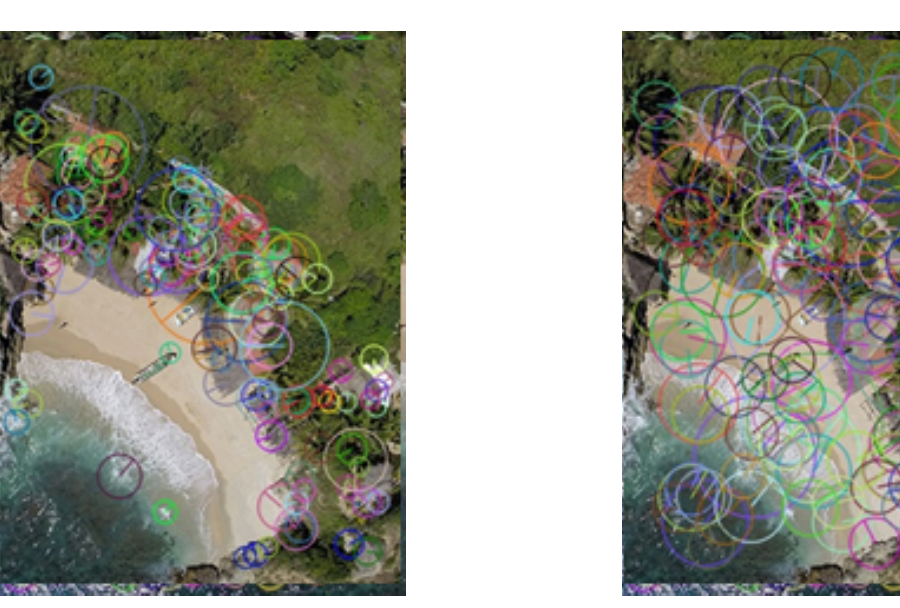
Figure 7. 10% highest response reachability SURF ranked points